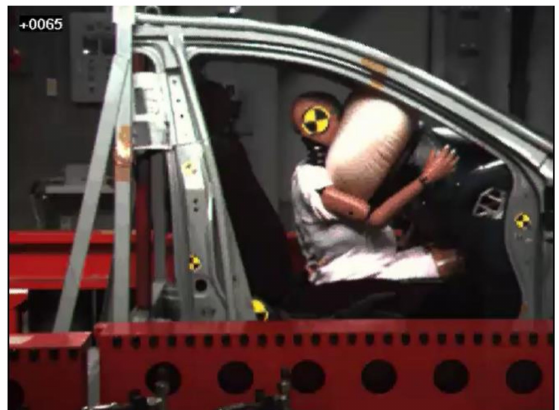
Figure 4. Instant at which the chest of the dummy made contact with the lower rim of the steering wheel in test